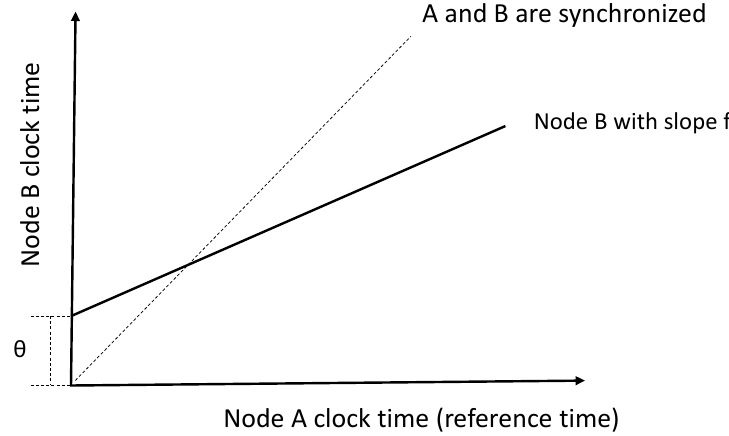
Figure 2. Clocks of sensor